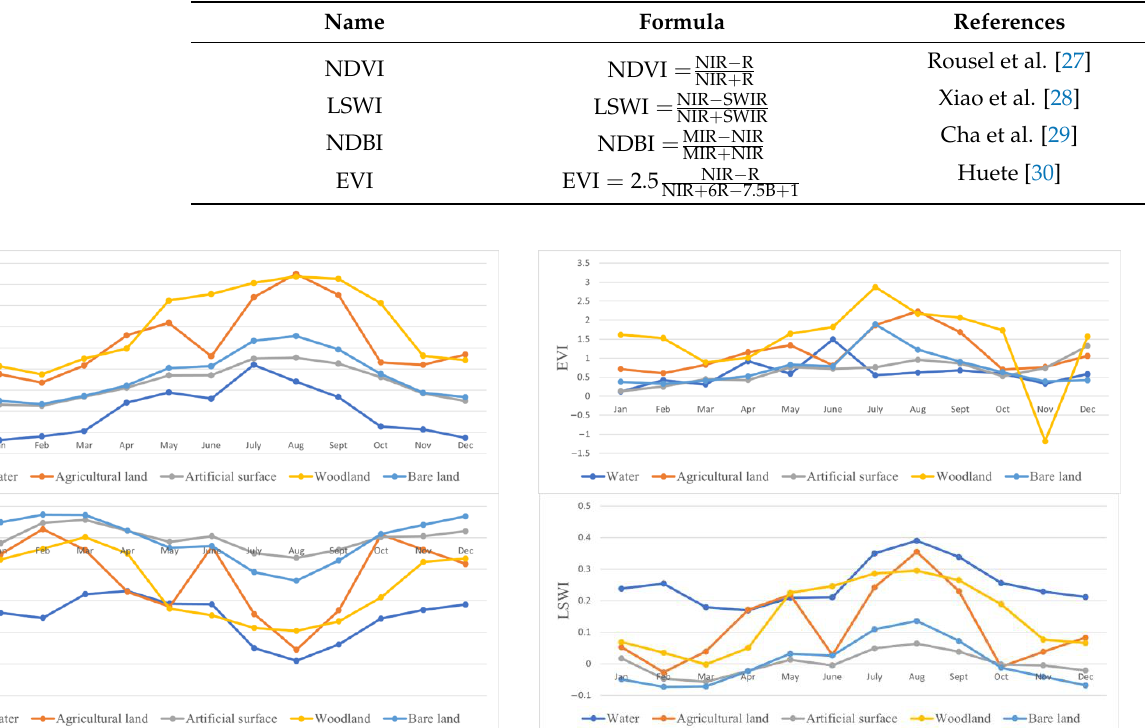
Figure 1. Spectral index characteristic curve. Table 1. The vegetation indices computed in this study from Landsat